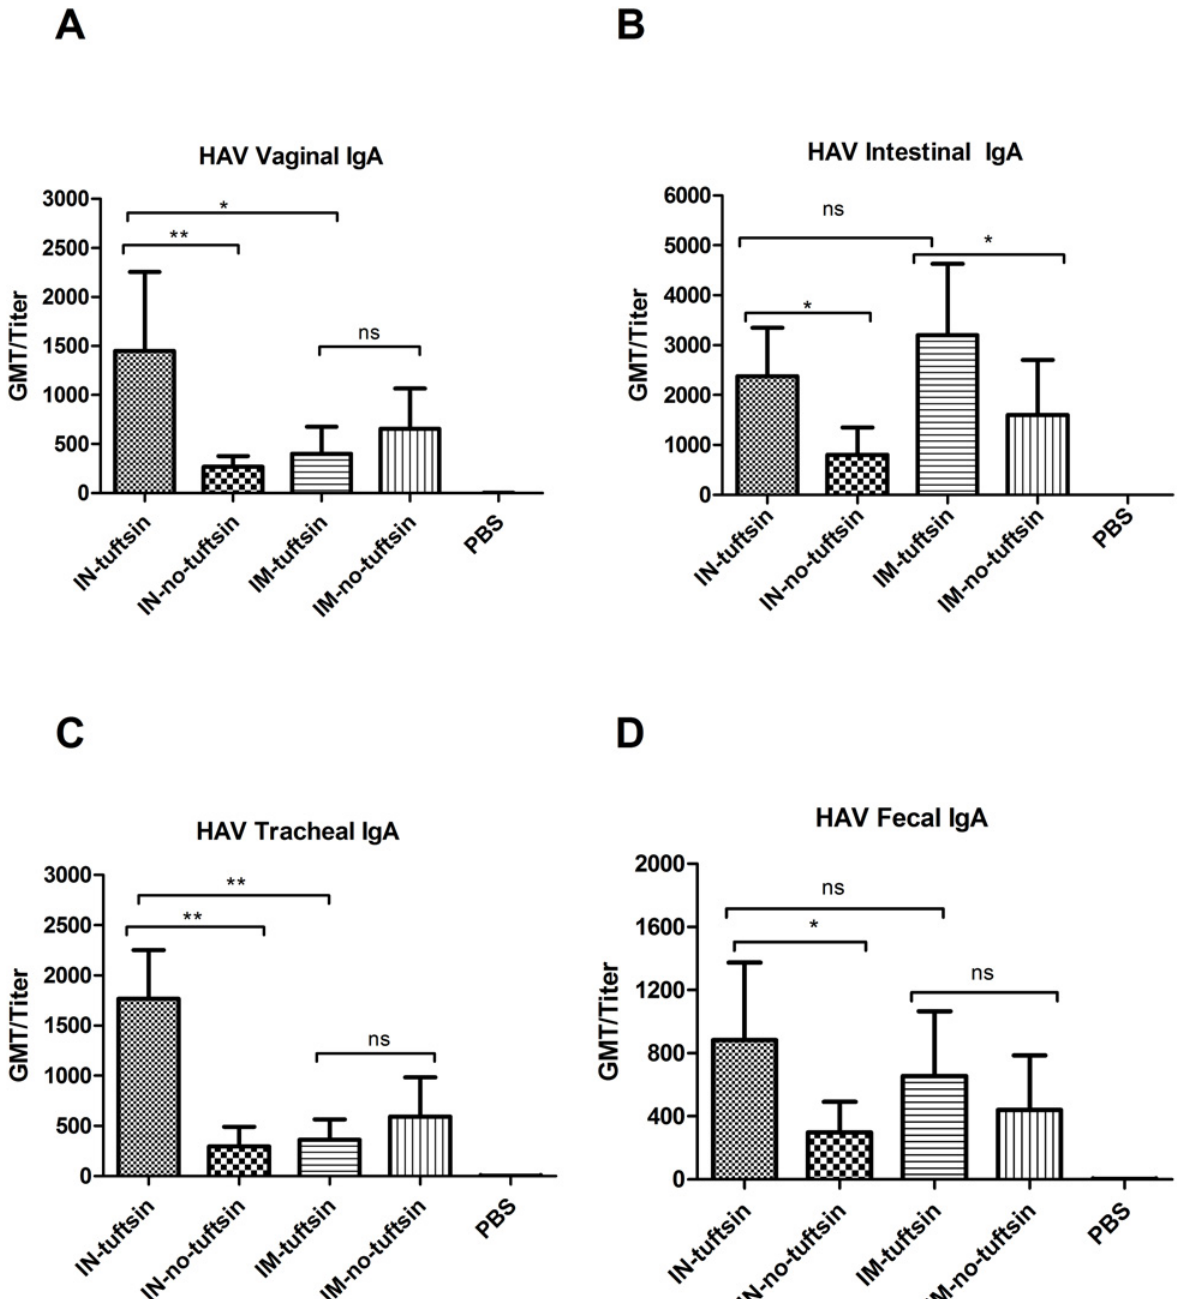
Fig 3. Profiles of HAV-specific IgA production in mucosal immune response to vaccination. HAV IgA was detected by indirect ELISA in (A) vaginal secretions, (B) intestine, (C) respiratory tract and (D) stool homogenates of the mouse groups immunized as indicated in Fig 2. Each serum effective dose (presented as the GMT) is the reciprocal value of the maximum positive dilution. Error bars represent the SEM. * , P < 0.05, ** , P < 0.01, *** , P < 0.001; ns, no significant